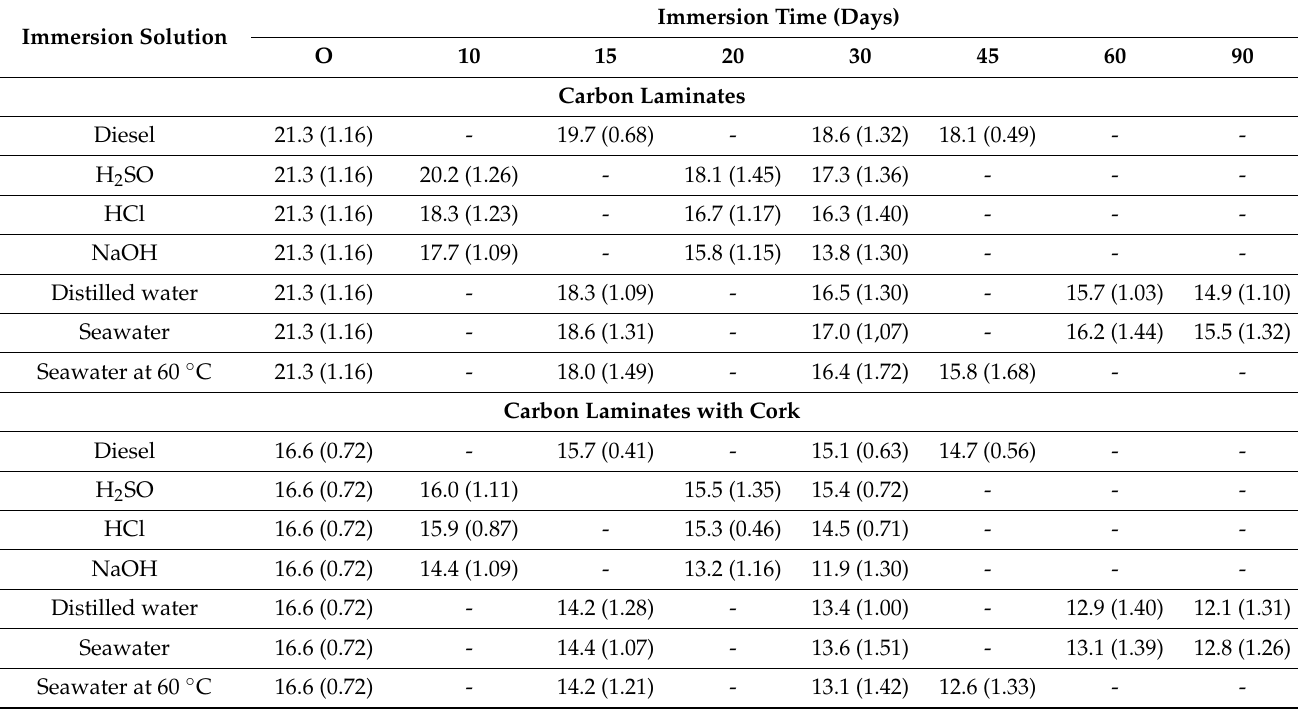
Table 7. Restored energy obtained for the different harsh solutions and immersion time (values in %).